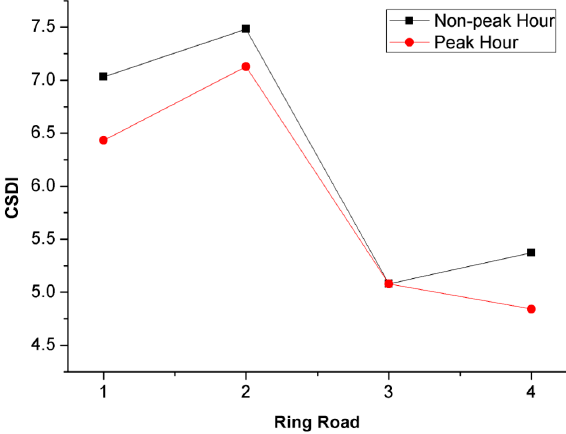
Figure 15. Average CSDI of the ring area.